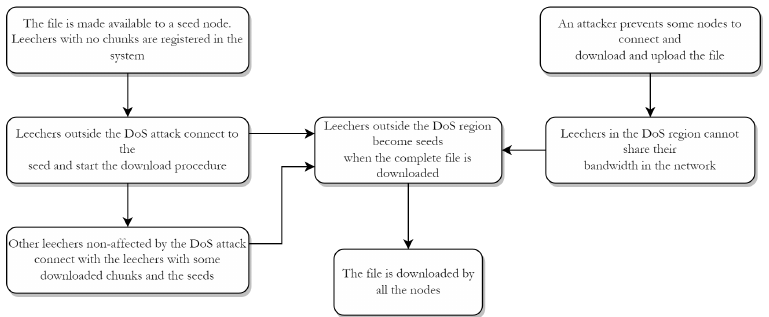
Figure 3. Flow chart for the operation of the DoS attack in the P2P